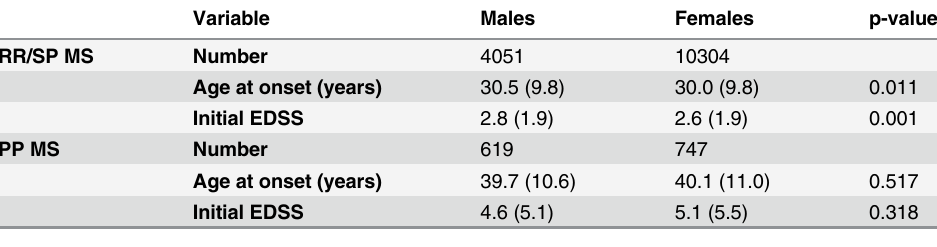
Table 1. Demographics of patients with relapsing- remitting (RR) / secondary progressive (SP) and primary progressive (PP) MS at the initial visit recorded to the MSBase